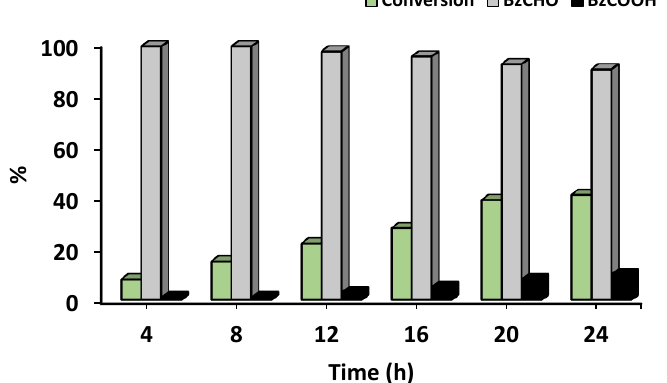
Figure 7. Effect of reaction time; conversion is based on benzyl alcohol; benzyl alcohol (100 mmol); TBHP (0.15 mmol); temperature (90 °C); O 2 balloon 1 atm; amount of catalyst (100 mg); BzCHO- Benzaldehyde; BzCOOH- Benzoic acid.